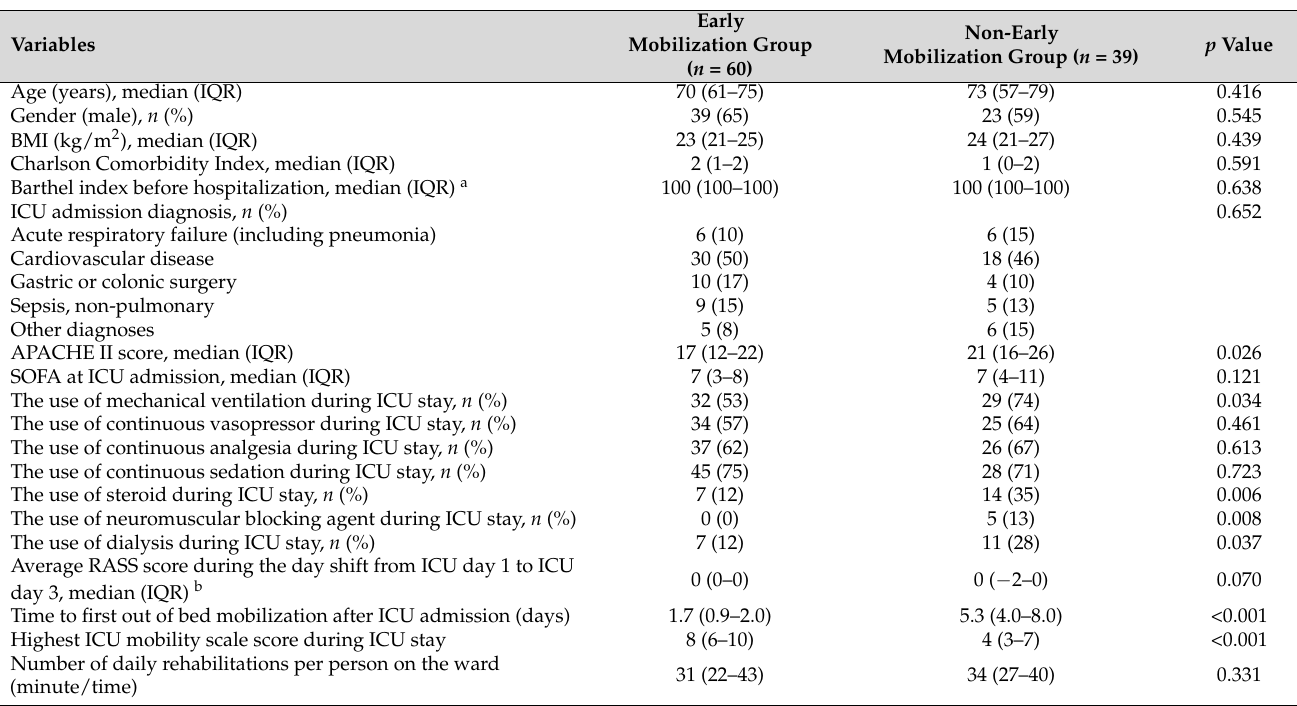
Table 1. Baseline